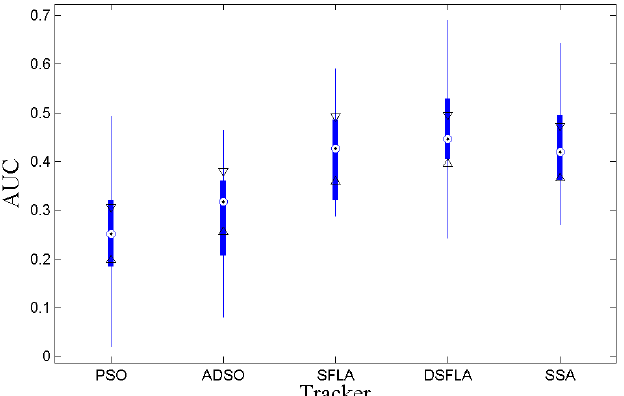
Figure 3. The boxplot of the AUC variable for all trackers.